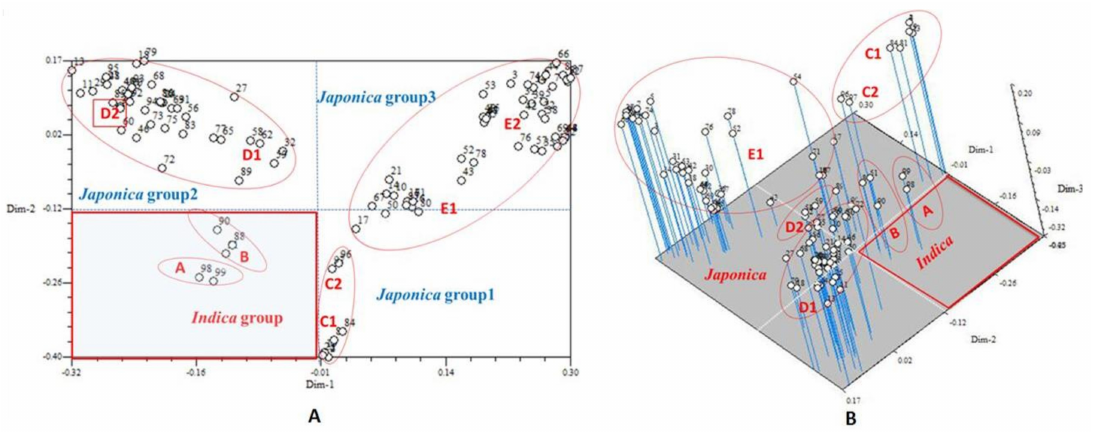
Figure 5. The 2D ( A ) and 3D ( B ) PCoA analysis of 99 rice samples based on 20 pairs of SSR primers.